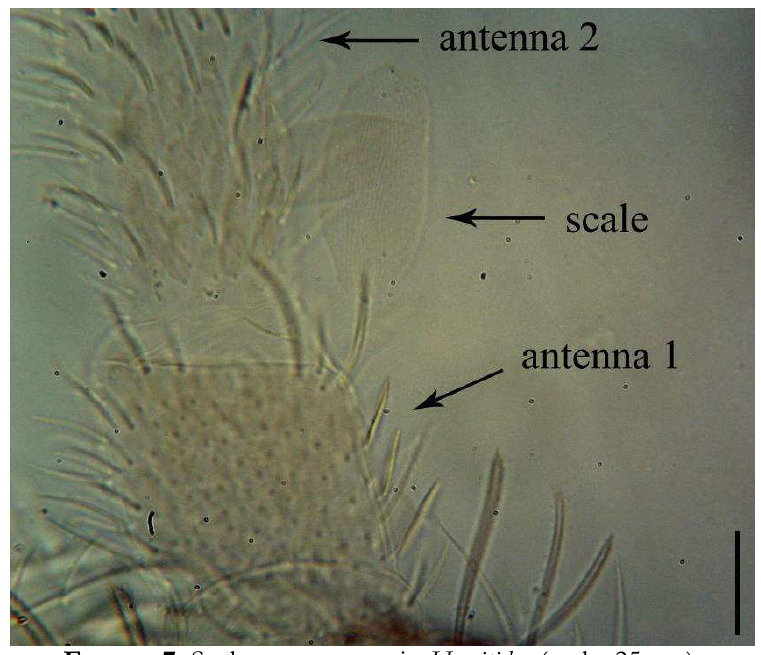
F IGURE 7. Scales on antenna in H. nitidus (scale: 25 µm)